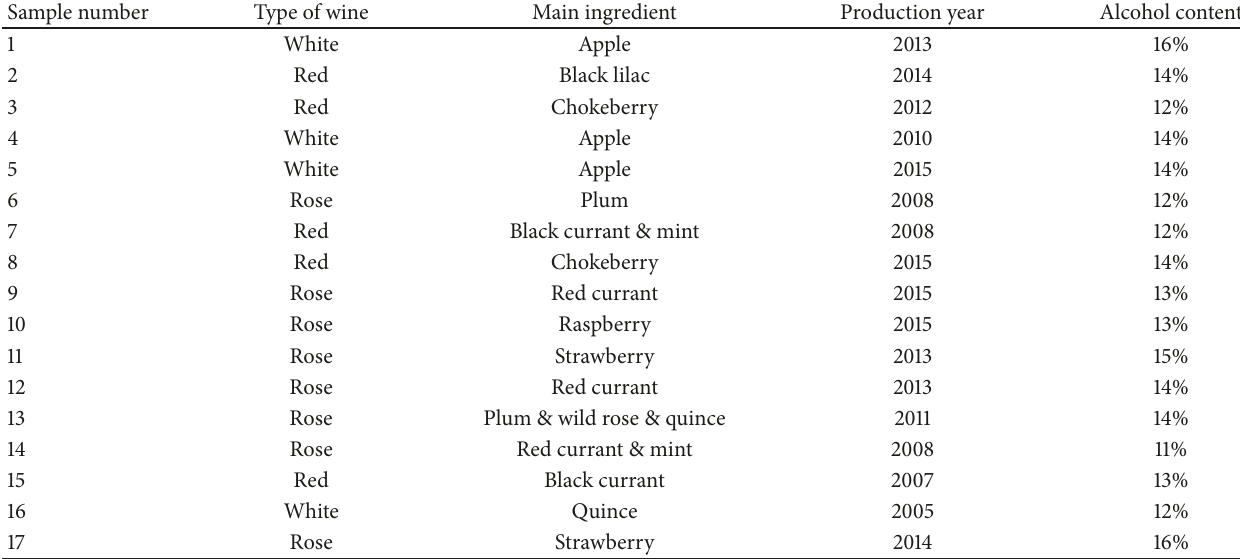
Table 2: Information on analysed samples of so-called home-made fruit wine. To determine alcoholic content of wine Alcolyzer Wine M/ME (Anton Paar) was used.